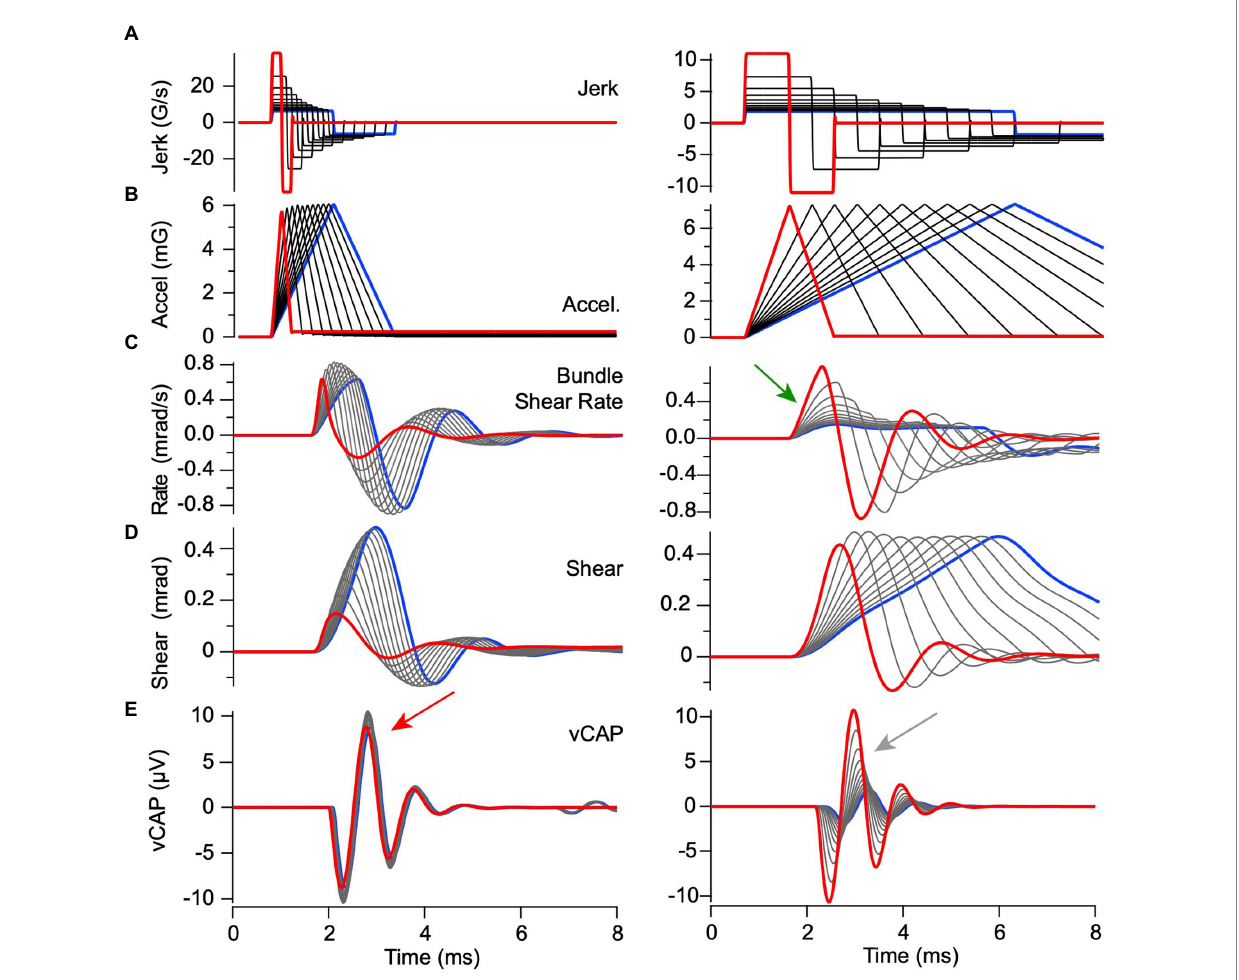
FIGURE 9 Predicted responses to BCV stimuli with constant peak acceleration but variable linear jerk. Model parameters are the same as previous figures and format of (A–E) is the same as Figure 8. Acceleration stimuli with rise times <0.8 ms evoked nearly equivalent onset bundle shear rates [ (C) left] and vCAPs [ (E) left], but stimuli with rise times >0.8 ms evoked bundle shear rates [ (C) left] and vCAPs [(Figure 6E) right] that scaled with linear acceleration. Results demonstrate a shift from acceleration sensitivity for high frequency stimuli to jerk sensitivity for low frequency stimuli, with a corner frequency near 1 kHz in adult guinea